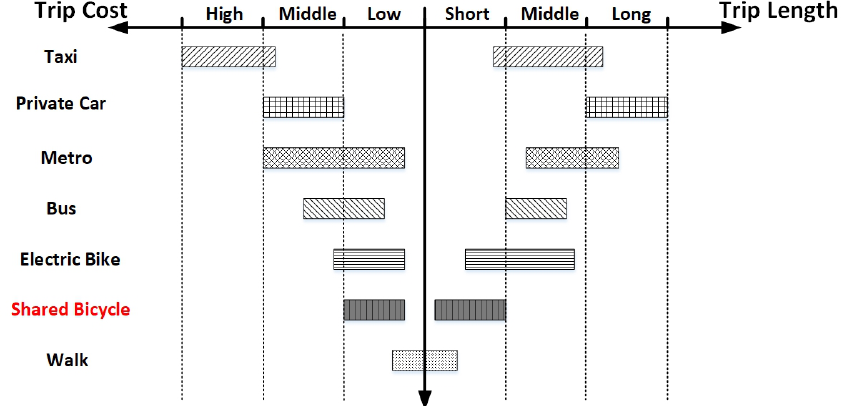
Figure 3. Comparison among different transport methods in urban area [11].